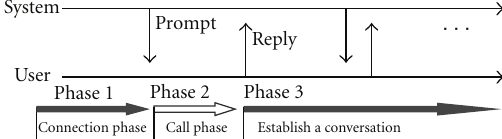
Figure 1: Phases of the dialog